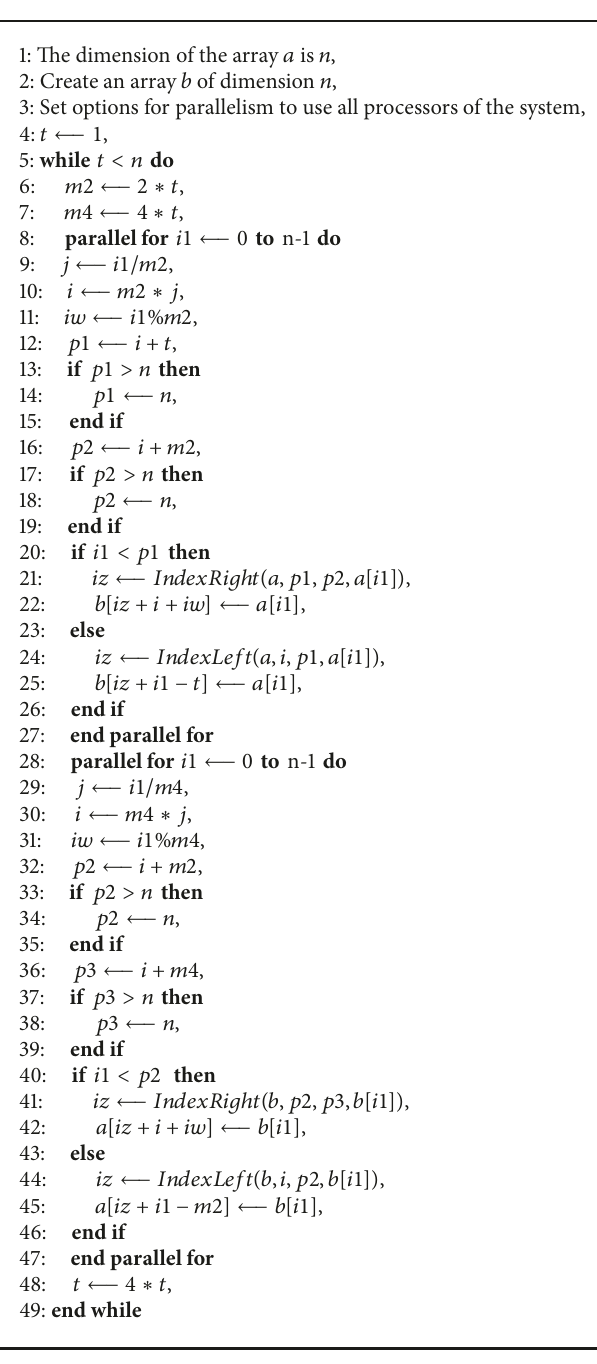
Algorithm 2: Proposed flexible parallel